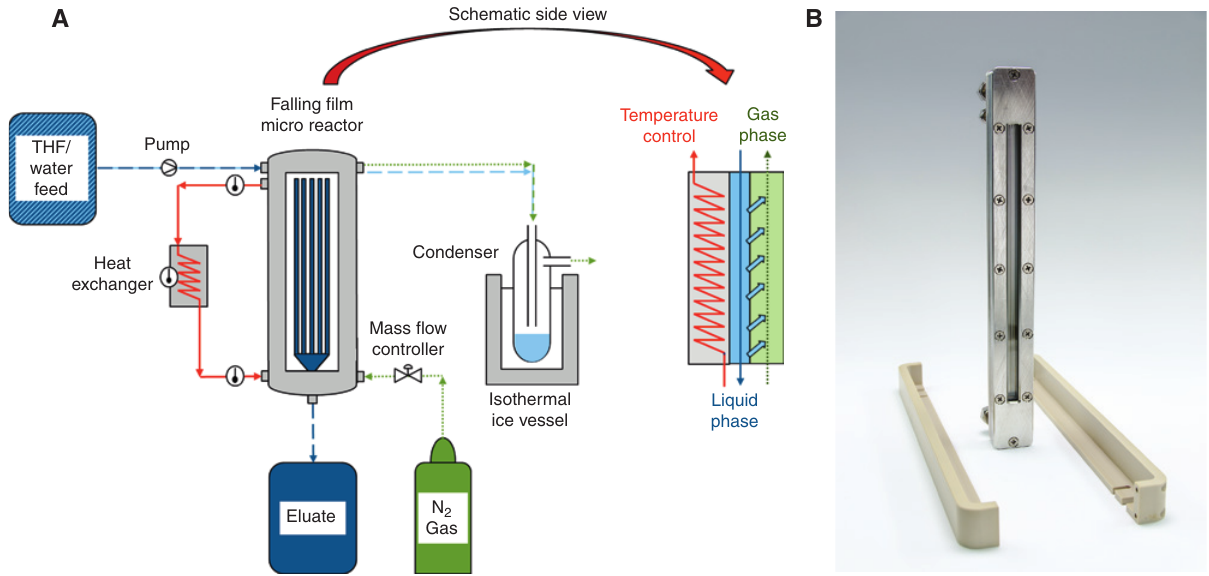
Figure 1: Flow chart of the experimental setup for the evaporation process and a photograph of the STACK-1x-FFMR-LAB-V2 with adjacent insulation